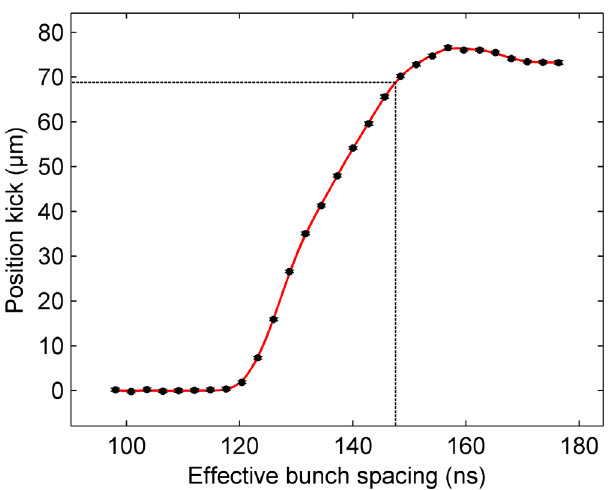
FIG. 14. Average difference between the kicked and unkicked positions of bunch 2 versus bunch spacing, for a constant kick corresponding to a DAC setting of 2000 counts. The errors (calculated as the sum in quadrature of the errors on the mean kicked and unkicked positions) are given. The red line is a cubic spline fit to the data, and the black lines indicate the point at which 90% of the full kick is delivered.